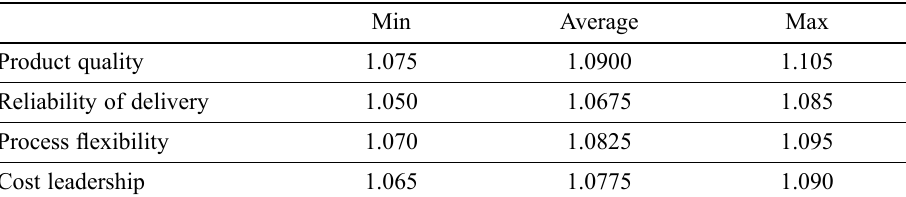
Table 1. Detailed integration strategy